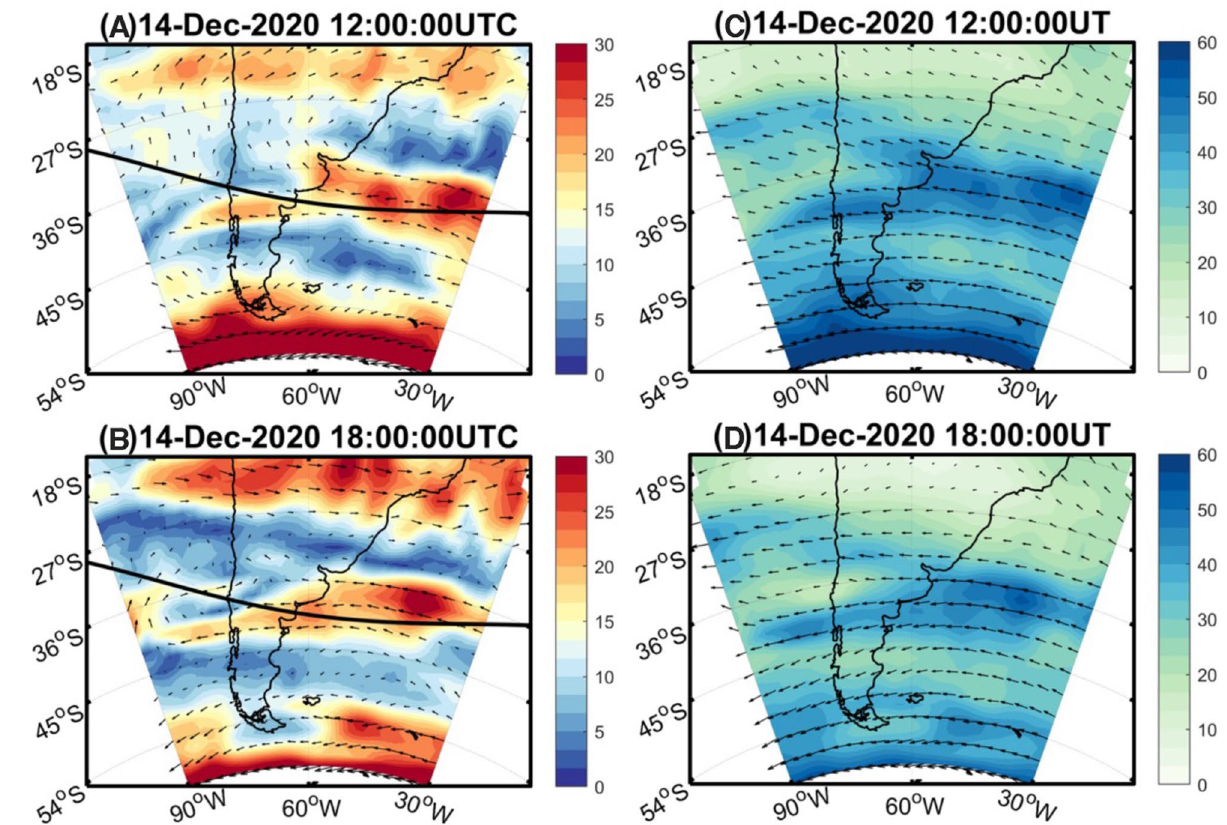
Figure 5. (Left panel) The wind shear (ms −1 ) obtained from the difference between the mesospheric (~ 80 km) and stratospheric winds(~ 40 km) for ( A ) 12 UT and ( B ) 18 UT on 14 December 2020. The eclipse center path at 350 km is also overlayed in ( A ) and ( B ). (right panel) ( C ) and ( D ) Similar to the ( A ) and ( B ) but